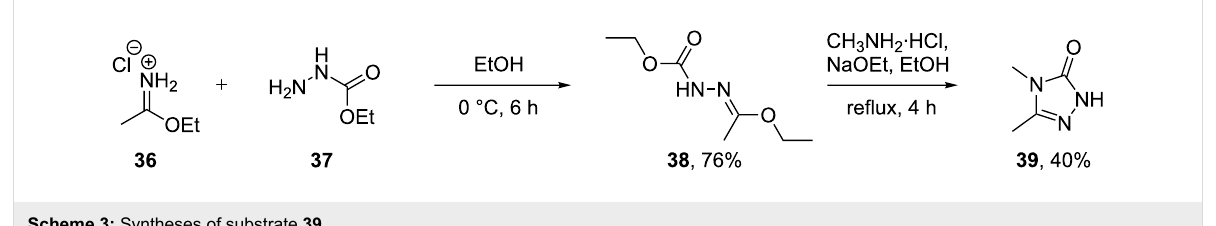
obtained although the reduced nucleophilicity and higher poten- tial for coordination of the triazole to the copper catalyst might inhibit catalyst turnover and account for